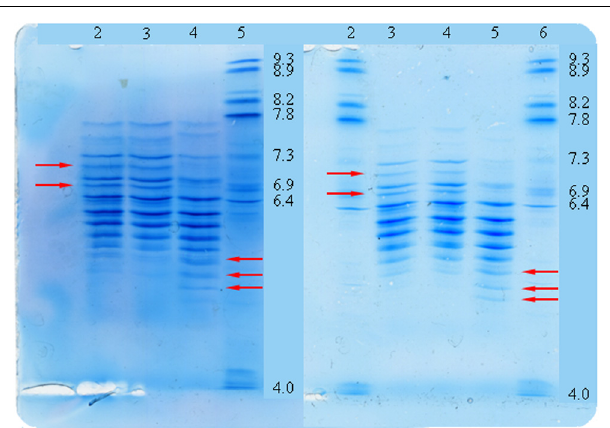
FIGURE 6 |Tenecteplase charge heterogeneity as detected by isoelectric focusing. Lanes left panel: 2 reference standard; 3 Metalyse; 4 Elaxim #140904E04; 5 pl-marker. Lanes right panel: 2 pl-marker; 3 reference standard; 4 Metalyse; 5 Elaxim #140903; 6 pl-marker. Arrows indicate shift of bands to the acidic region as compared to reference